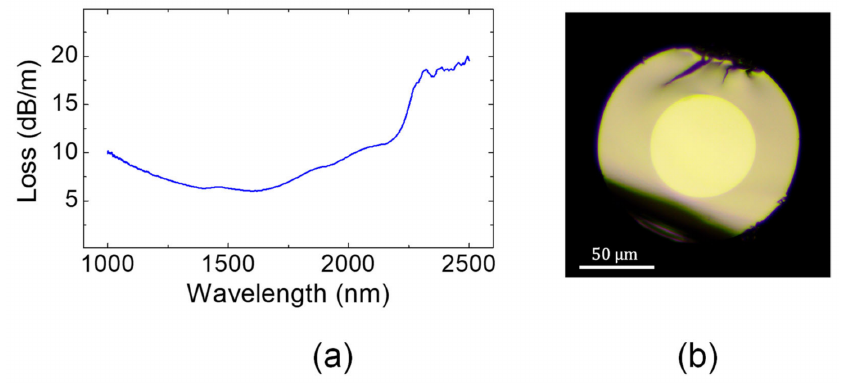
Figure 6. ( a ) Optical attenuation curve and ( b ) cross-sectional view of the multimode T72La8/T60Y5 fiber, which has a numerical aperture of